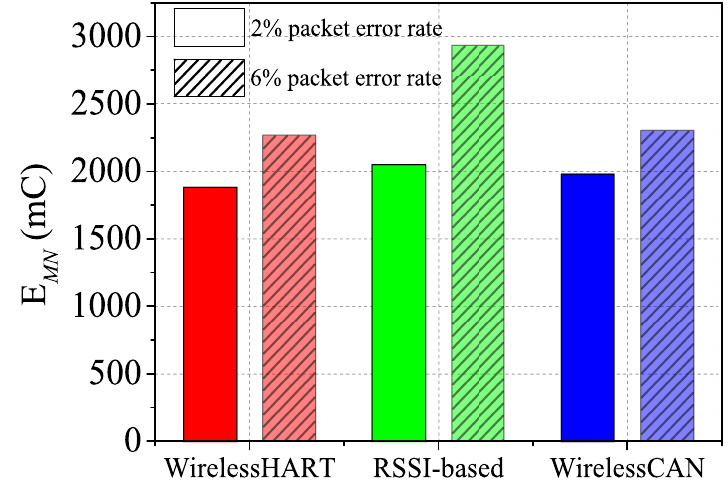
Figure 14. Energy consumption comparison ( E MN